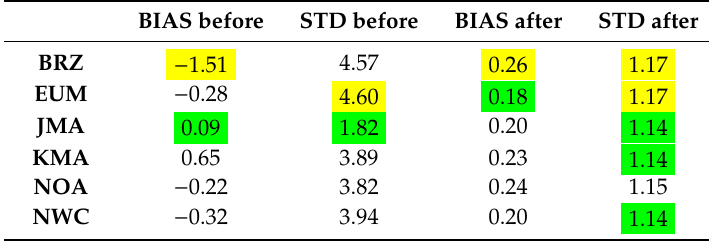
Table 17. The same as Table 16, but with CQI >= 80%. BIAS before STD before BIAS after STD after BRZ − 1.57 4.56 0.26 −